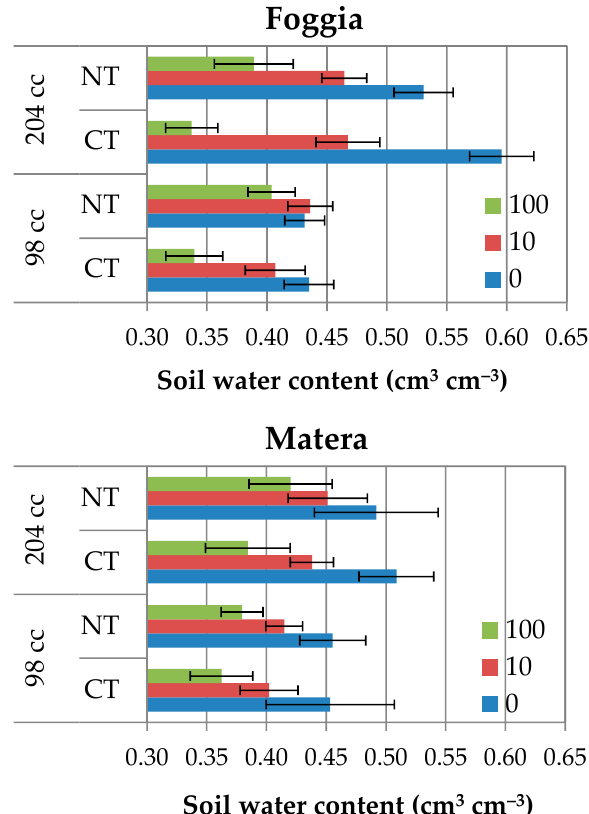
Figure 2. Soil water retention corresponding to h = 0, − 10, and − 100 cm, obtained under conventional tillage (CT) and no-tillage (NT) using soil cores of 98 and 204 cm 3 (98 and 204 cc) at Foggia and Matera sites.